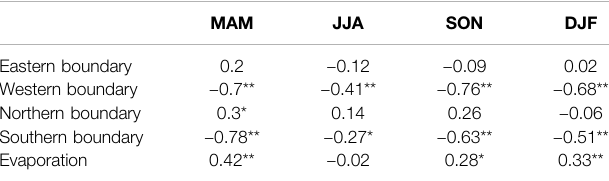
signi fi cance test. The PRR in spring, summer, autumn and winter were about 0.24, 0.23, 0.3 and 0.28, respectively, and all seasons showed an upward trend with trend coef fi cients of 0.36, 0.09, 0.38 and 0.35, respectively (regression coef fi cients 0.44, 0.09, 0.68 and 0.61%/10a, respectively). The 95% signi fi cance test was passed in spring, autumn and winter.